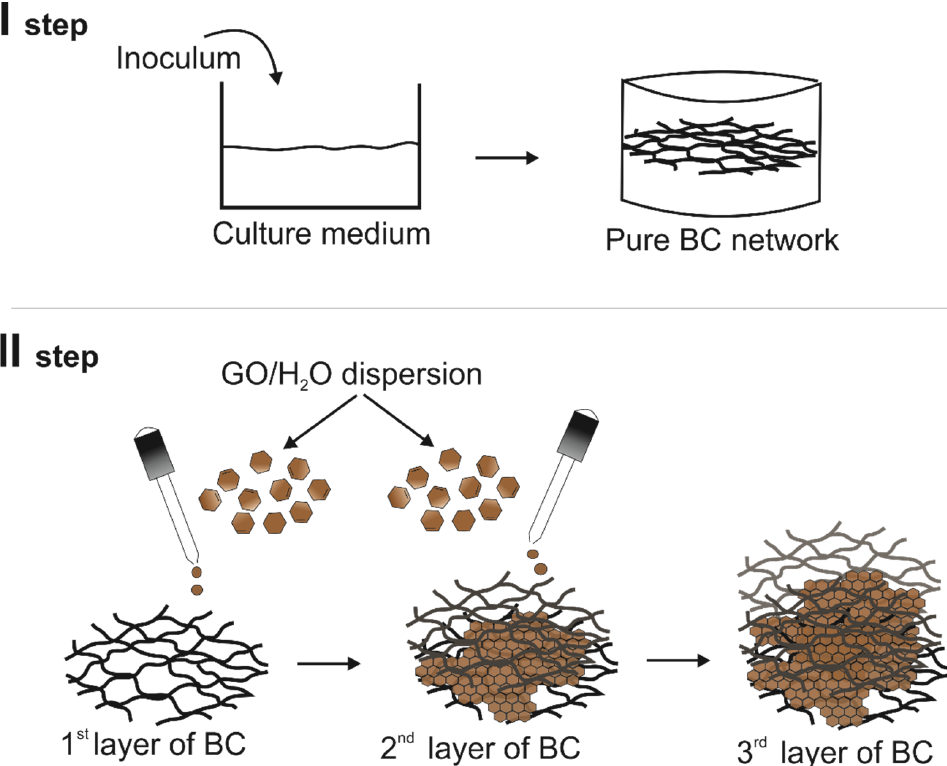
Figure 1. The process of obtaining modified BC.